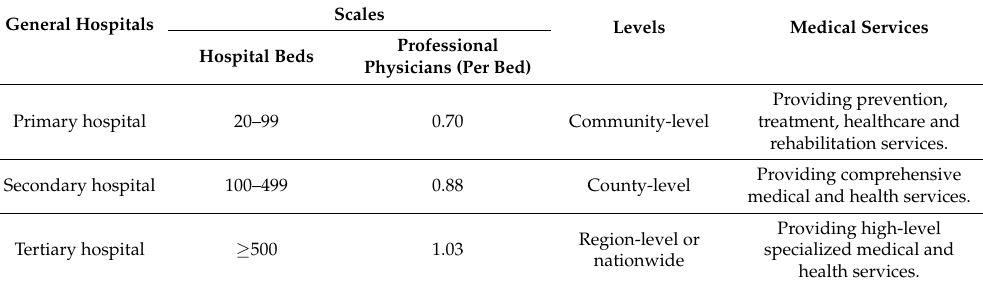
Table 2. Major characteristics of general hospitals in current China [43].